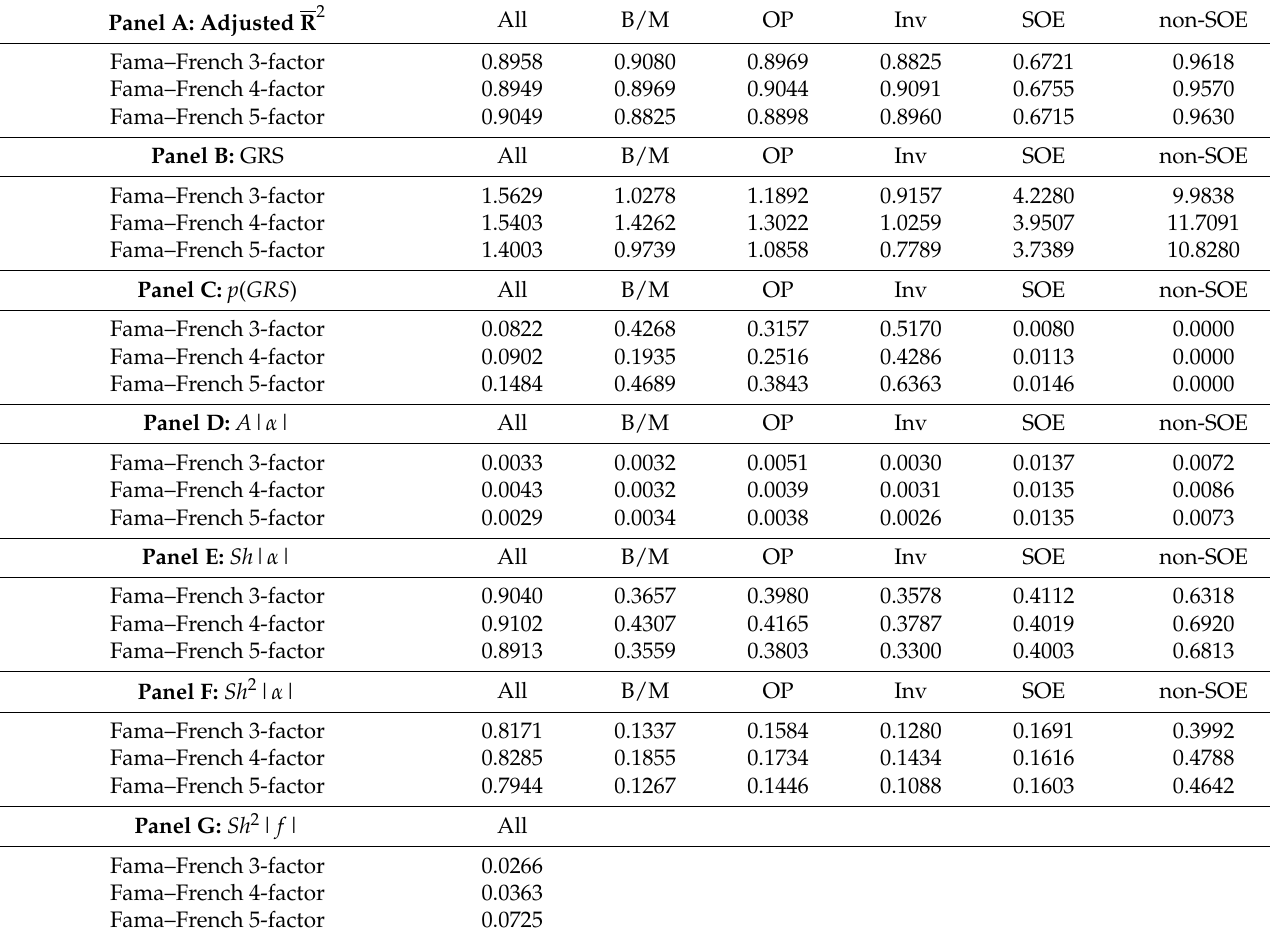
Table 5 shows consistent results of the Fama–French five-factor model’s superiority as evidenced in the tests of panels A to G for all 27 portfolios (column A of all panels) and for three sets of nine portfolios with each sorted by size and a combination of B/M (column B/M of all panels), operating profitability (column OP of all panels) and investment (column Inv of all panels). Despite there being different rankings for the three- and four- factor models among the portfolios, all results consistently show the superiority of the five-factor model (columns All, B/M, OP and Inv of panel D). Table 5. Characteristics of double-sorted portfolios. The table provides the summary results of the multivariate regressions for portfolios formed by size and a combination of book-to-market (B/M), profitability (OP), investment (Inv), SOE and non-SOEs. Portfolios are formed in July of year t to June of year t + 1 from the stock sorted in December of year t − 1. The portfolio formation and book-to-market (HML), profitability (RMW) and investment (CMA) factor construction follow Fama and French’s (1993, 2015) methodology. Summary results show the average value of all adjusted R-squared (Panel ( A )) and the absolute intercepts ( A | α | ) (Panel ( D )) of all portfolios from the respective regressions (Eq. ( 1 ), ( 2 ) and ( 3 )). GRS in Panel ( B ) is the Gibbons et al. (1989) test statistic and its p -value, p ( GRS ), is shown in Panel ( C ). Sh ( α ) in Panel ( E ), Sh 2 ( α ) in Panel ( F ) and Sh 2 ( f ) in Panel ( G ) are the Sharpe ratio for intercepts, its maximum squared value and the maximum squared Sharpe ratio for the model’s factors, respectively. We apply these five tests to all portfolios (All) and portfolios formed by size and a combination of book-to-market (B/M), profitability (OP), investment (Inv). The tests also show the results for the portfolios sorted by size and a combination of SOEs and non-SOEs. The sample is from September 2008 to July